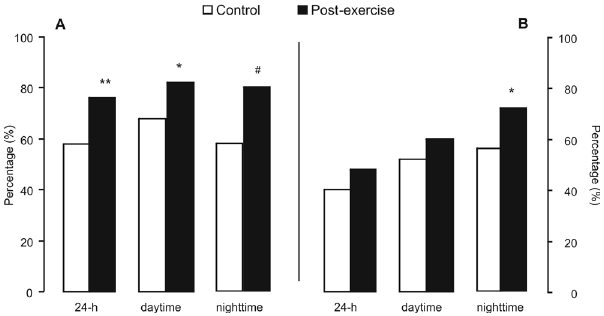
Figure 2 - Percentage of patients with twenty-four hour (24 h), daytime, and nighttime normal (< 130/80 mmHg for 24-h, < 135/85 mmHg for daytime, and < 120/70 for nighttime) ABP after a single exercise session (post-exercise) or a nonexercise control period (control.). A: systolic blood pressure; B: diastolic blood pressure. Asterisks denote a significant differ- ence from control period (*p=0.02; **p=0.007). # Tended to be different from control period (p=0.058)